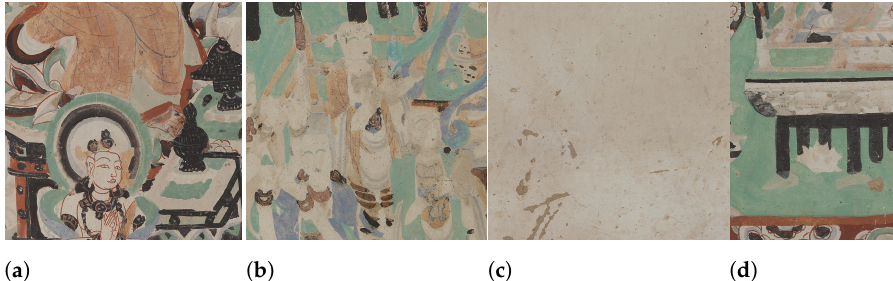
Figure 6. Ground-truth images selected for discussion. ( a ) First image (697 × 701 pixels) was chosen because it contains a face, that we consider a challenging case for inpainting. ( b ) Second image (681 × 674) is very color diverse. ( c ) Third image (828 × 800) is a homogenous colour, where it will be easy to check for color artifacts in the inpainted result. ( d ) Fourth image (582 × 841) is a scene with decorating motifs, where edges reconstruction can be